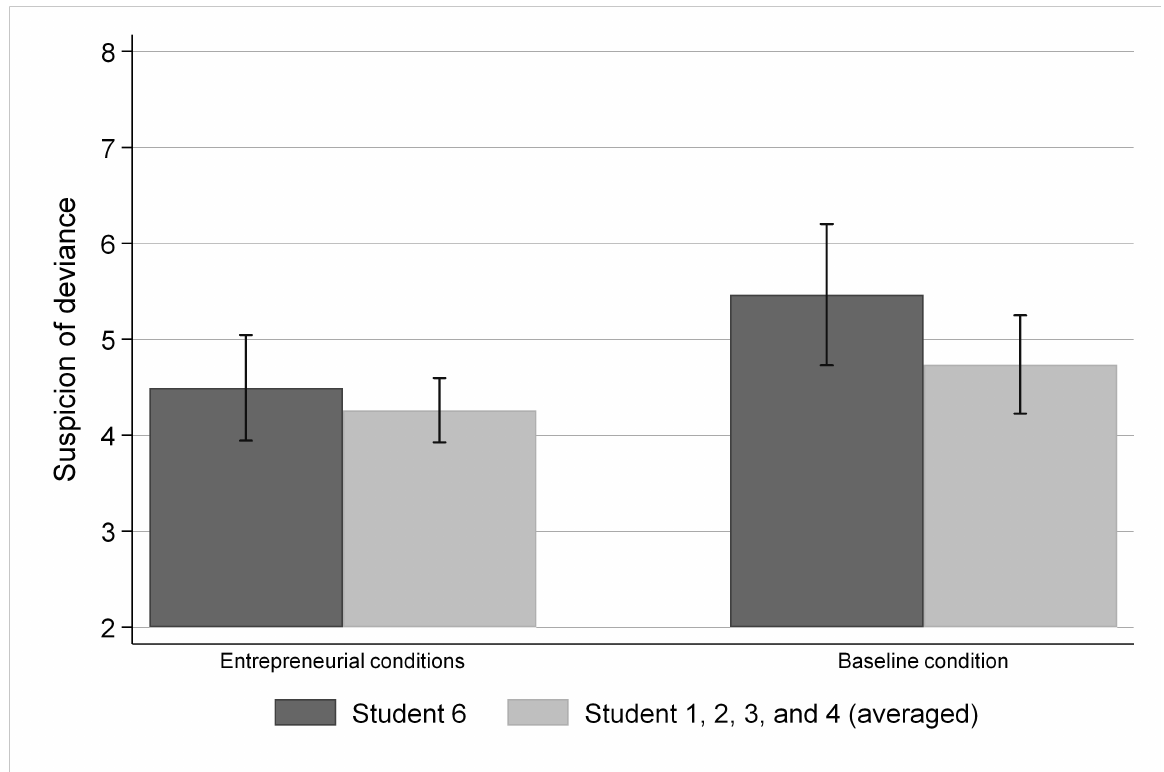
Figure 3: Within-subject comparisons of likelihood that the student in question changed his response in the Low-Accusability/Entrepreneurial conditions and the Low-Accusability/Baseline condition in study 2. The error bars indicate the 95 percent confidence interval. Possible values of the y axis range from 1 (very unlikely) to 10 (very likely). Separate measures for students 1, 2, 3, and 4 were averaged in all the Low- Accusability/Entrepreneurial conditions and the Low-Accusability/Baseline condition (Cronbach’s alpha = 0.88). The measure is the response to the following question: “How likely is it that student X wrote the